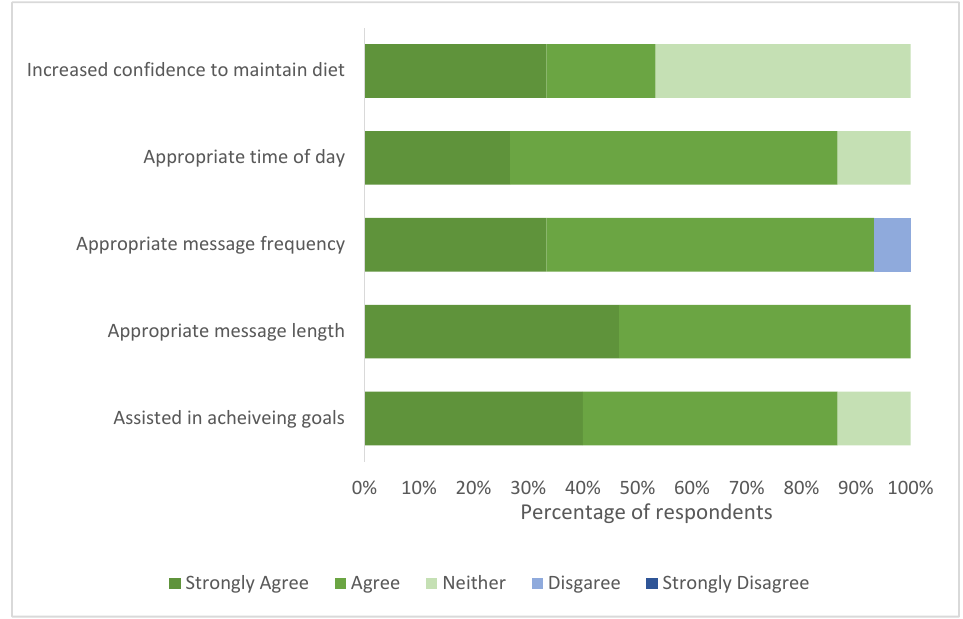
Figure 5. Intervention participant ( n = 15) opinions on the acceptability and ease of preparation of the foods on the AusMed diet program and confidence in ability to adhere.